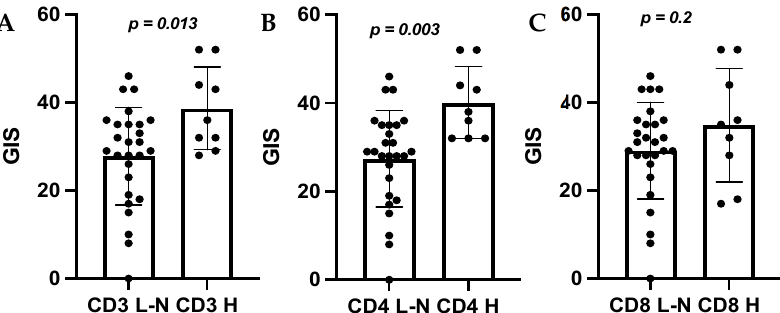
Figure 4. Comparison of mean GIS score by high (H) and low–normal (L–N) immune cell counts. ( A ): CD3, ( B ): CD4, ( C ): CD8. Abbreviations: GIS, genomic instability score.